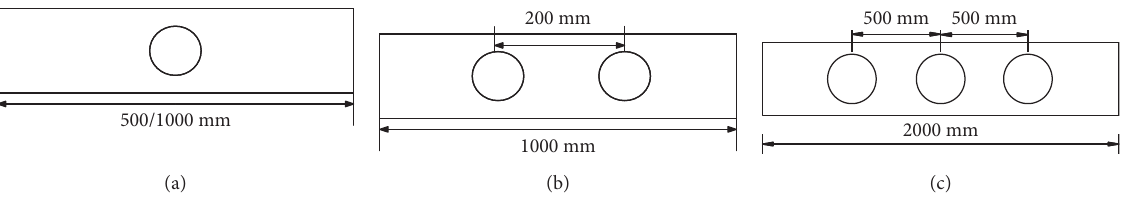
Figure 2: Location and spacing of circular holes in the web. (a) Web with one circular hole. (b) Web with two circular holes. (c) Web with three circular holes.